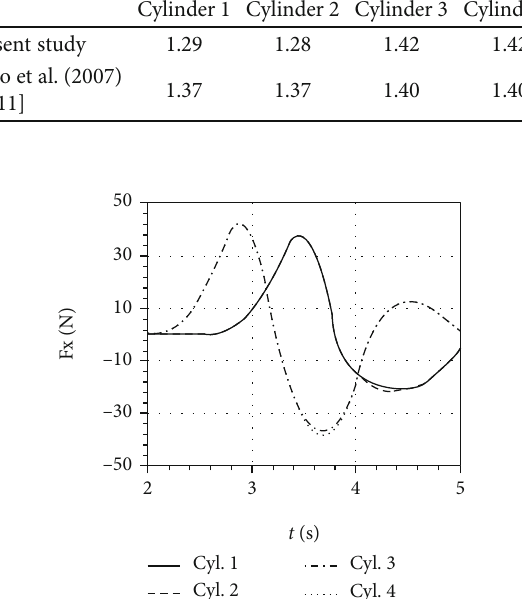
Figure 8: Time evolution of the in-line force on the square arrangement for H / h = 0 : 25